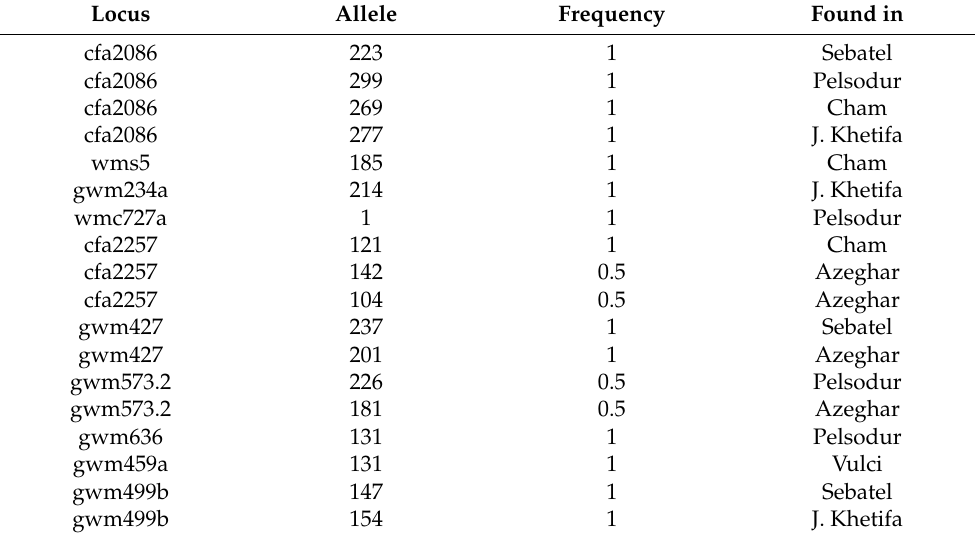
Table 5. Private alleles (defined by a set of populations currently active).